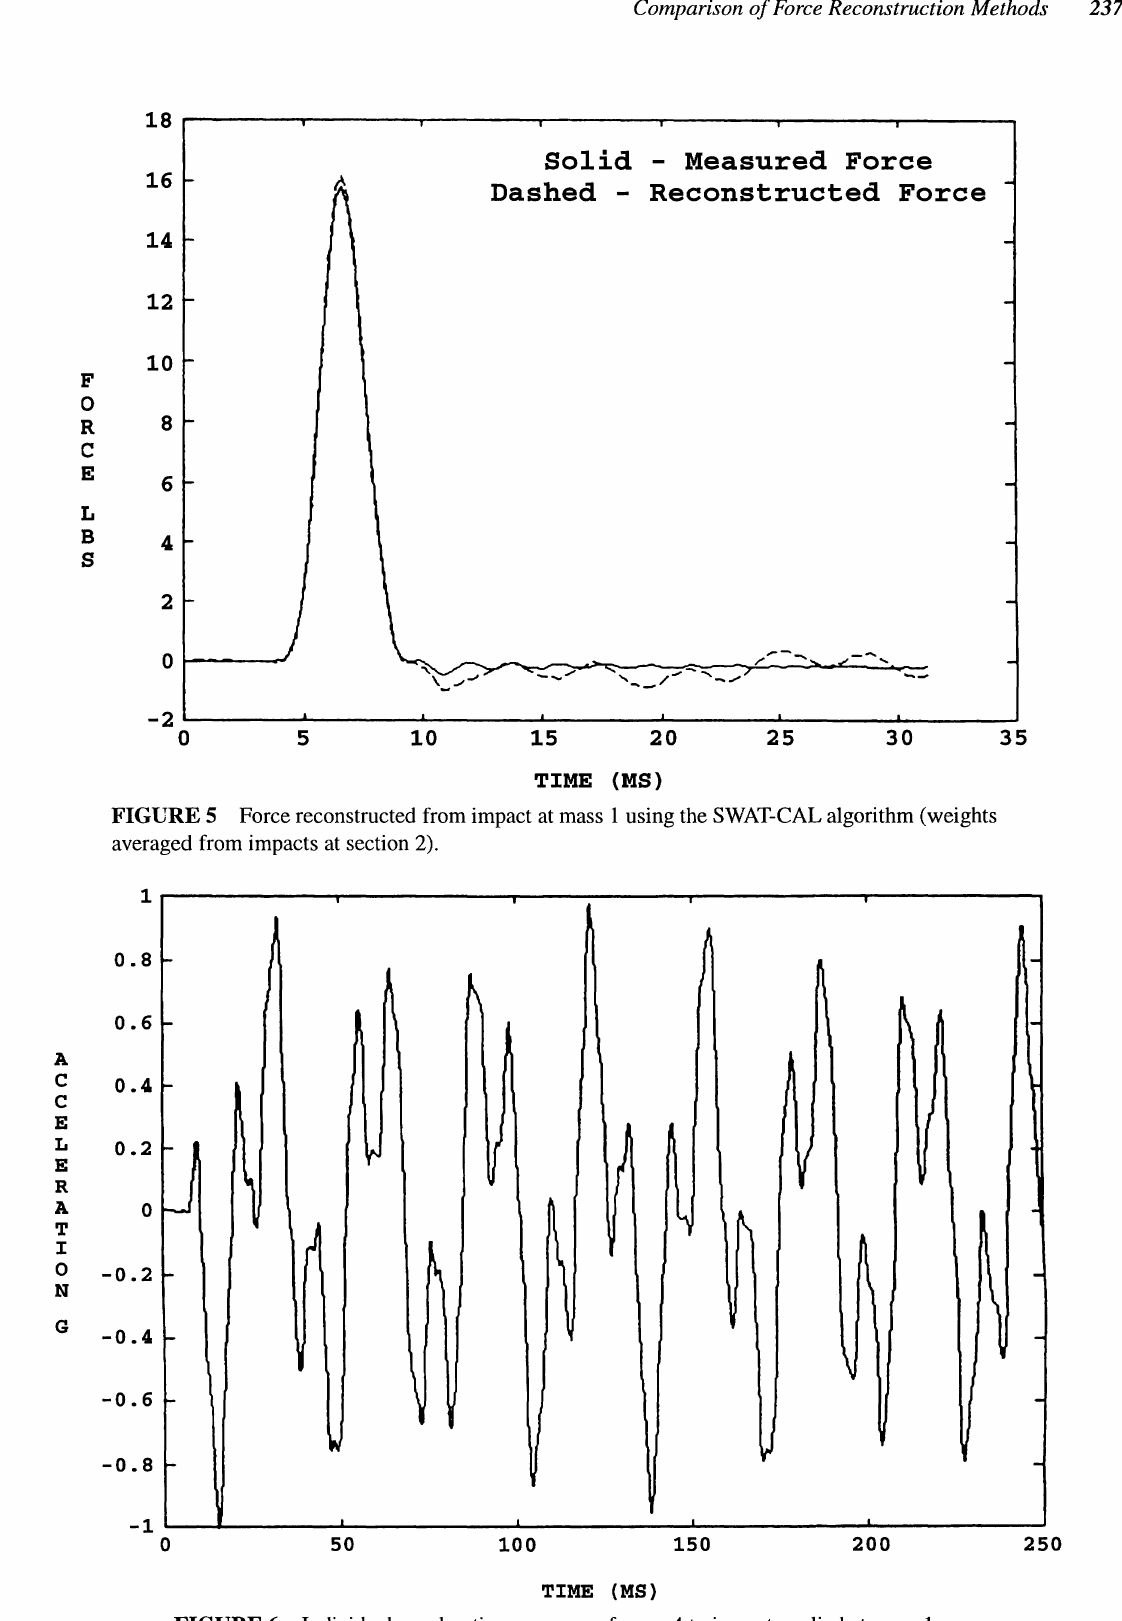
FIGURE 6 Individual acceleration response of mass 4 to impact applied at mass